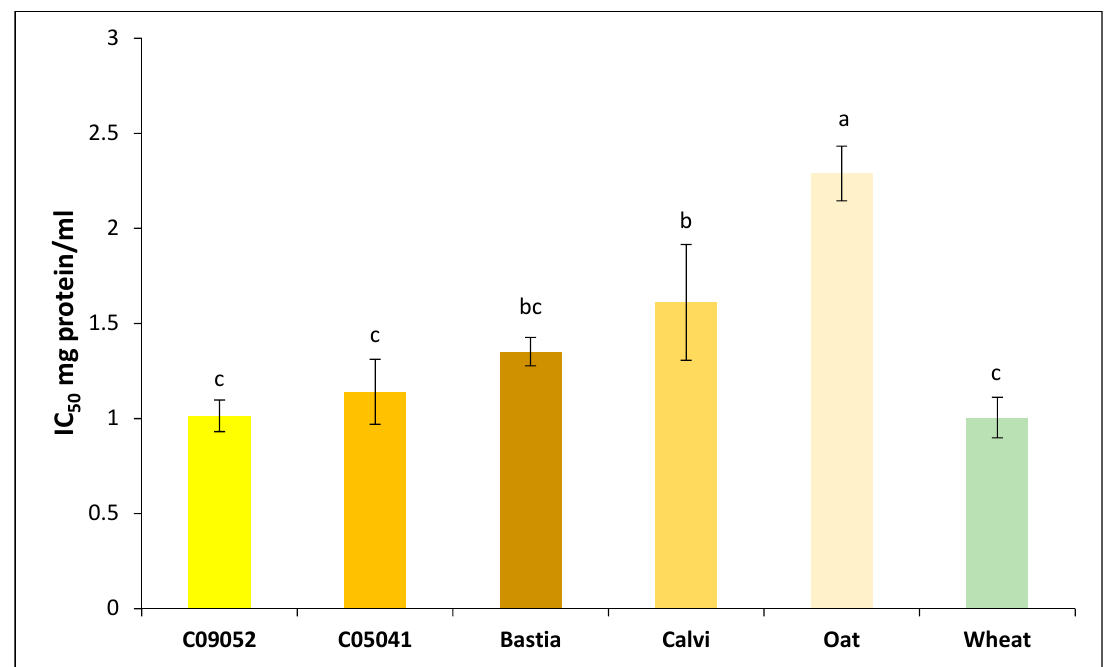
Figure 5. Antidiabetic activity (based on DPP-IV inhibition) of canaryseed, oat and wheat peptide 3K permeates prepared following flours in vitro gastrointestinal digestion and 3K MWCO ultrafiltration. IC 50 : inhibitor concentration that inhibits enzyme activity by 50%. Different letters represent statistical difference according to the LSD method by multiple range test ( α = 0.05) with a confidence level of 95%. Values represent mean ± SD (n = 3).